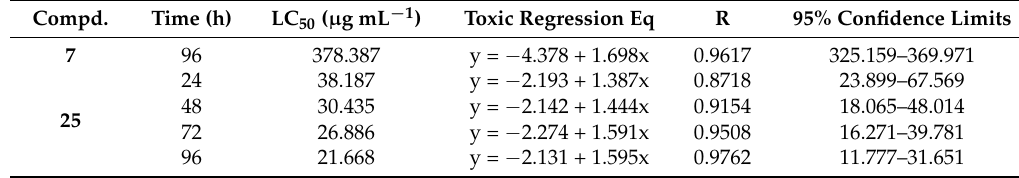
Table 5. The Zebrafish Embryo Acute Toxicity of Compounds 7 and 25